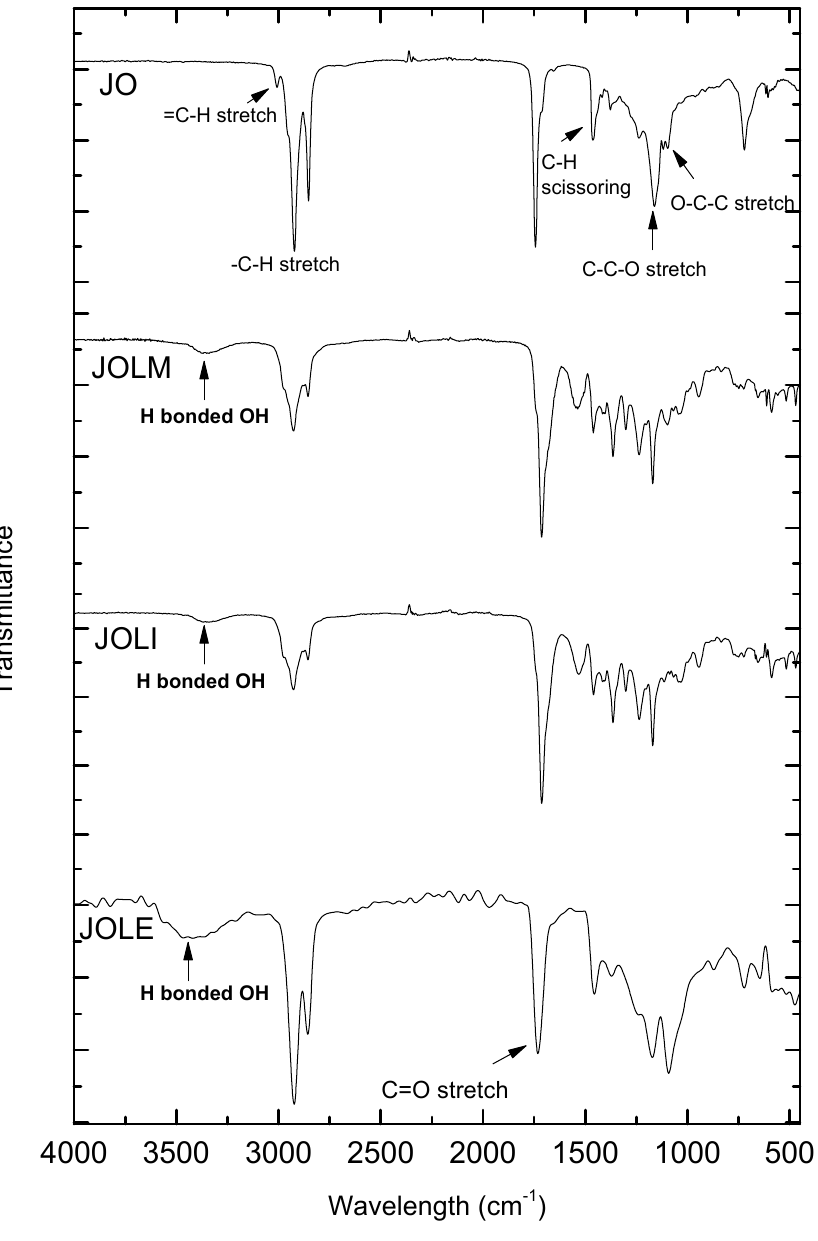
Figure 1. FTIR spectra of JO, JOLE, JOLM and JOLI.